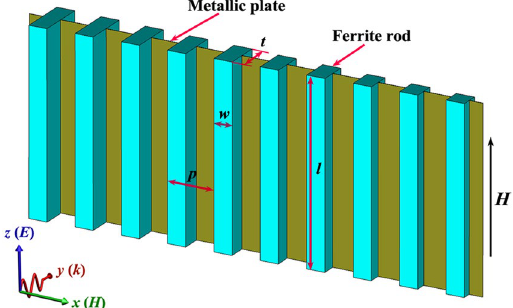
Figure 1. Schematic diagram of the magnetically tunable metasurface.